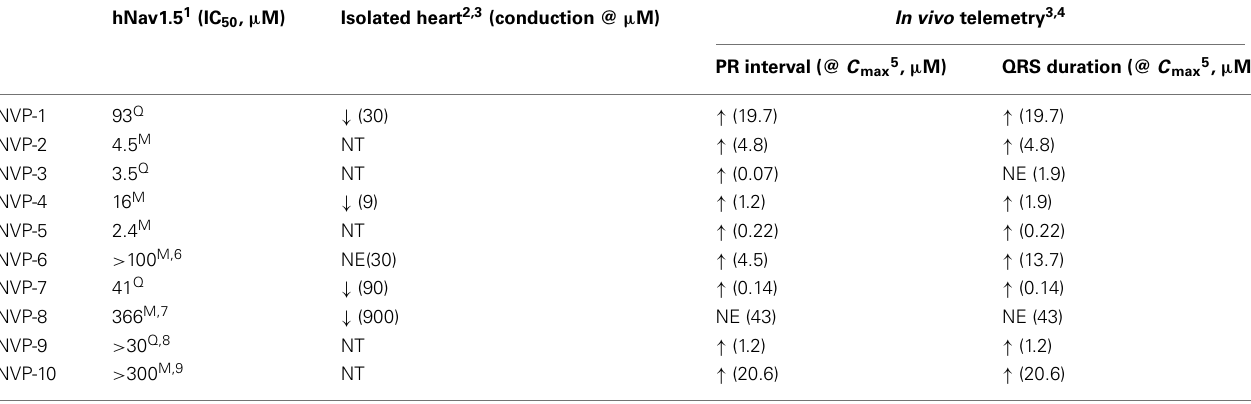
Table 1 | Pre-clinical profiles of compounds with cardiac sodium channel